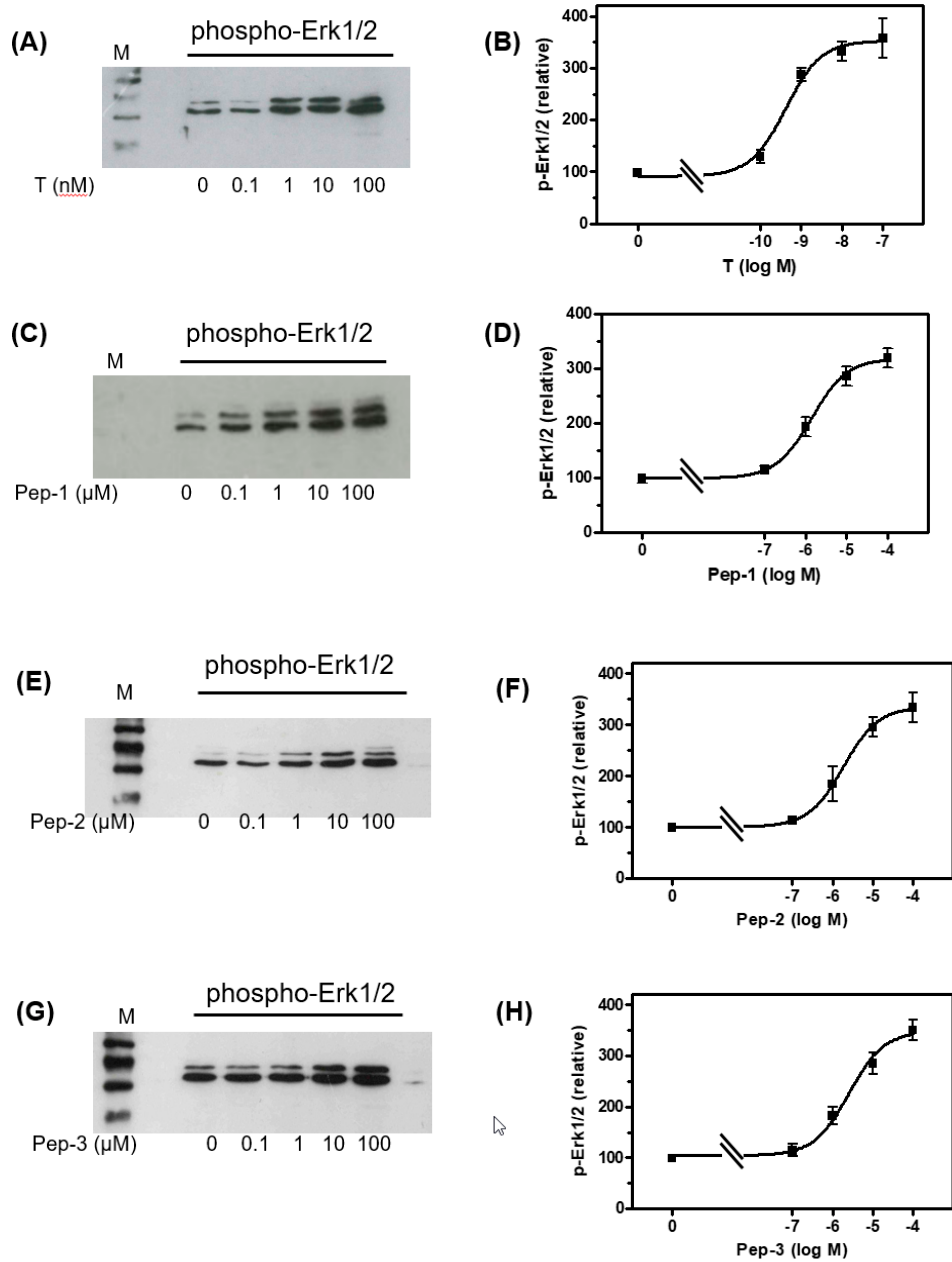
Figure 3. Western blot of phospho-Erk1/2 in Sertoli cells. The 93RS2 cells were stimulated for 30 min with various concentrations of testosterone or peptides. ( A ) Phospho-Erk1/2 detection in Western blot after stimulation with T, ( C ) after stimulation with Pep-1, ( E ) after stimulation with Pep-2 or ( G ) after stimulation with Pep-3. ( B ) The semi-logarithmic plot of relative p-Erk1/2 signals reveal for T an EC 50 = 0.42 ± 1.54 nM, ( D ) for Pep-1 an EC 50 = 1.39 ± 1.36 µM, ( F ) for Pep-2 an EC 50 = 2.59 ± 1.05 µM and ( H ) for Pep-3 an EC 50 = 1.87 ± 1.6 µM. For each diagram: n = 3; means ± SD.